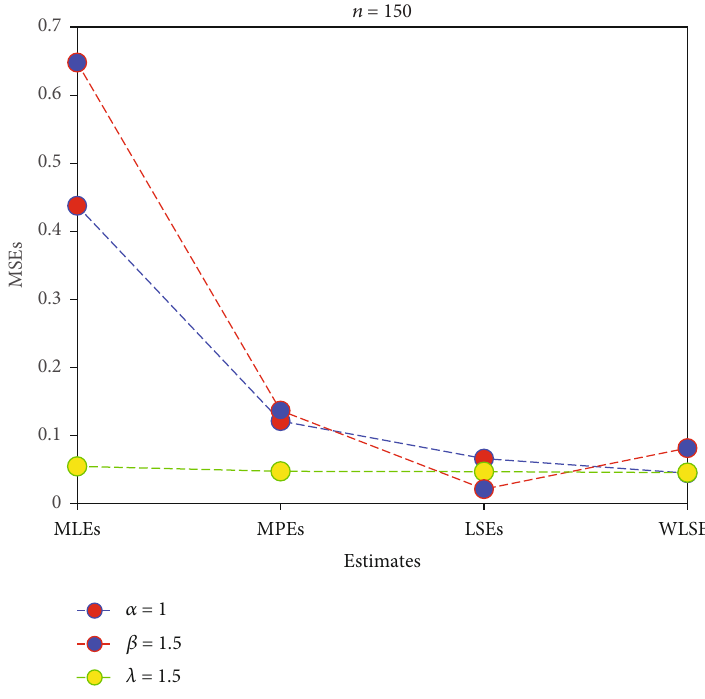
Figure 10: MSEs using n = 150 : α = 1 , β = 1 : 5 , and λ = 1 : 5 .